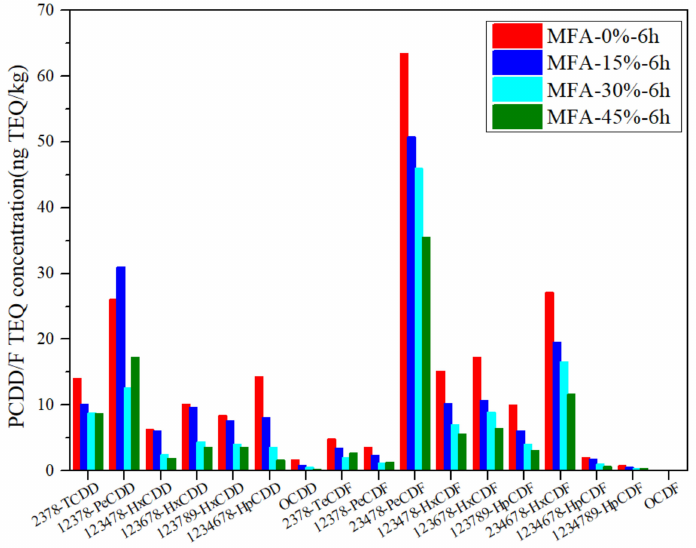
Figure 4. Concentrations of 17 2,3,7,8-substitued PCDD/Fs after MC treatment for 6